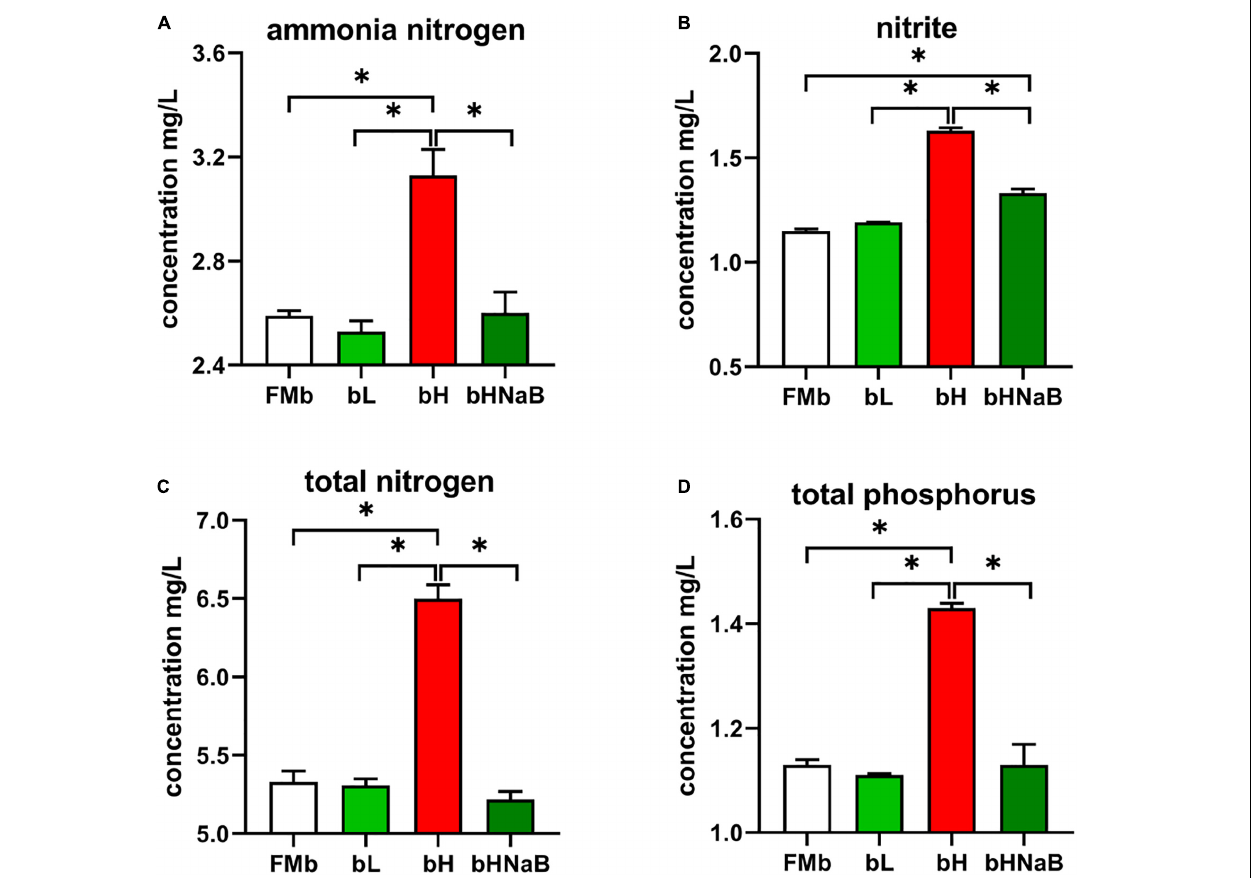
FIGURE 1 | Detection of harmful substances in aquaculture water. The concentrations of (A) ammonia nitrogen, (B) nitrite, (C) total nitrogen concentration, and (D) total phosphorus were determined by Specification for Marine Monitoring-Part 4: Seawater analysis (GB 17378.4-2007). * P <